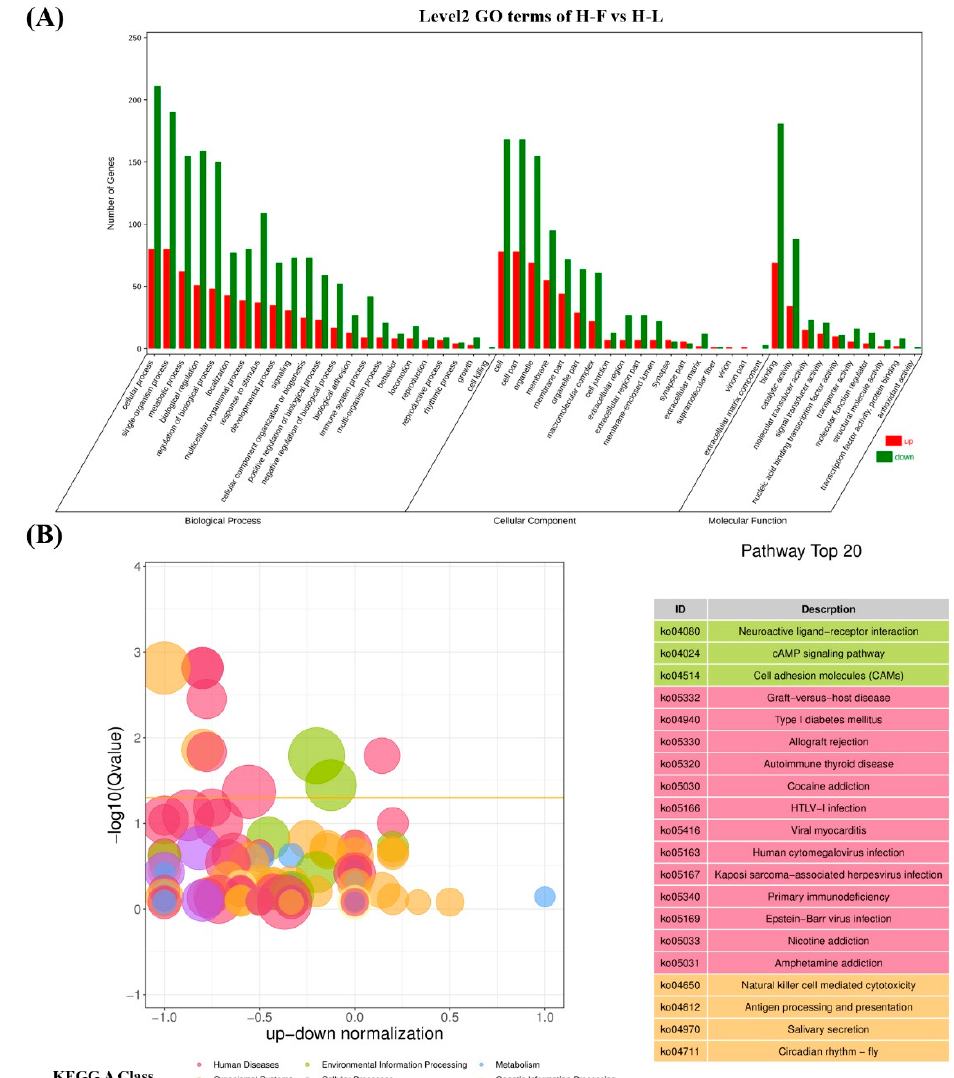
Figure 5. The top gene ontology (GO) and KEGG enrichment analysis. ( A ) The top 20 GO enrich- ment analysis of differential expressed genes (DEGs). ( B ) The top 20 KEGG enrichment analysis of